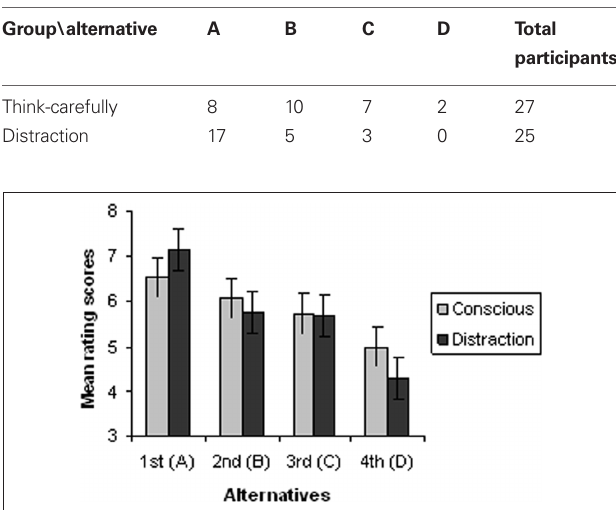
Table 2 | Number of participants rating each option highest, in each of the two groups.